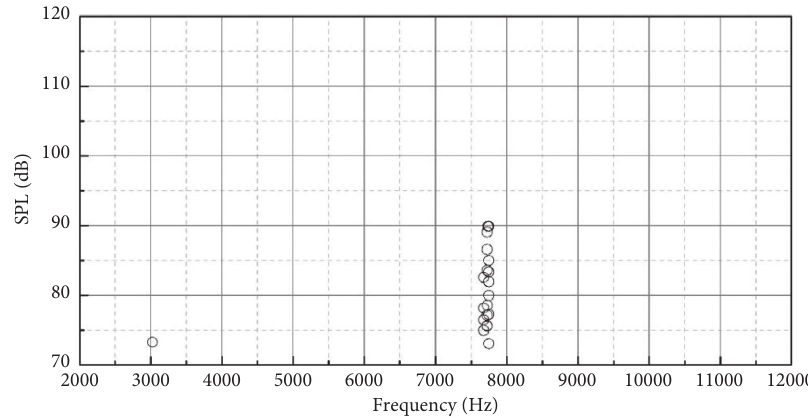
Figure 14: Noise distribution during the dynamometer test after